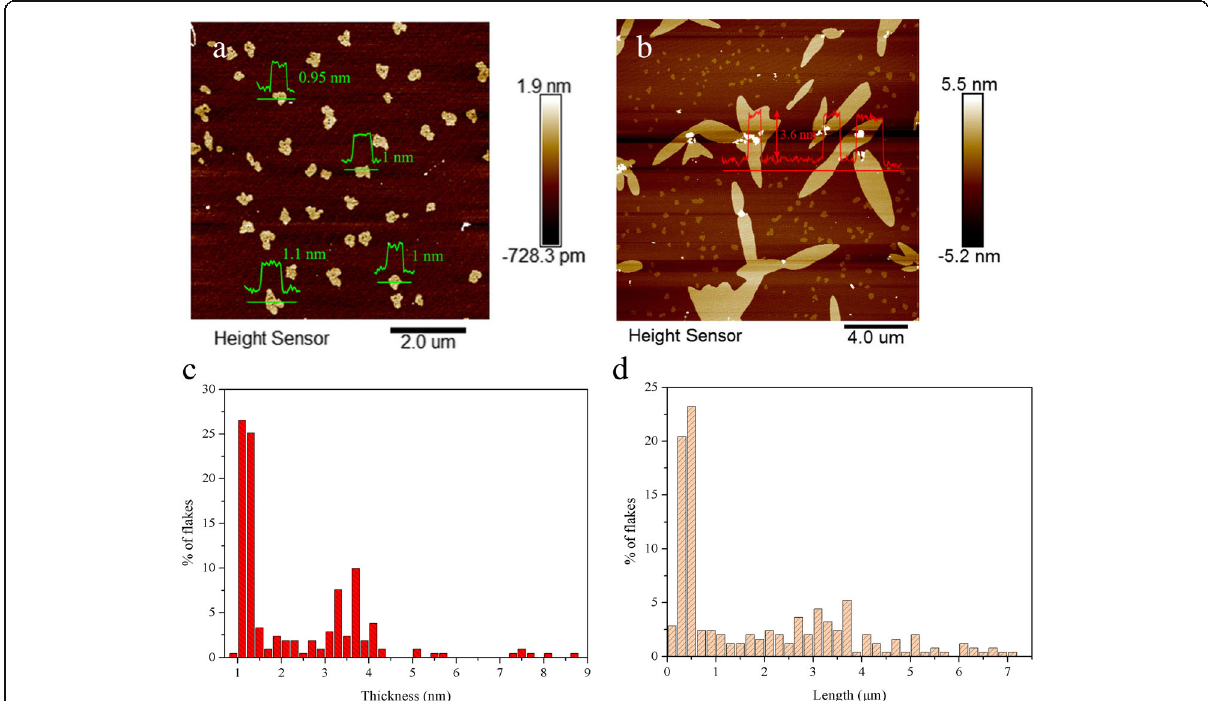
Fig. 5 Representative AFM images of a mono-layer graphene flakes and the corresponding height profiles, b few-layer graphene flakes and the corresponding height profiles, c thickness distribution of flakes, and d length distribution of flakes ( c and d were obtained from AFM analysis of